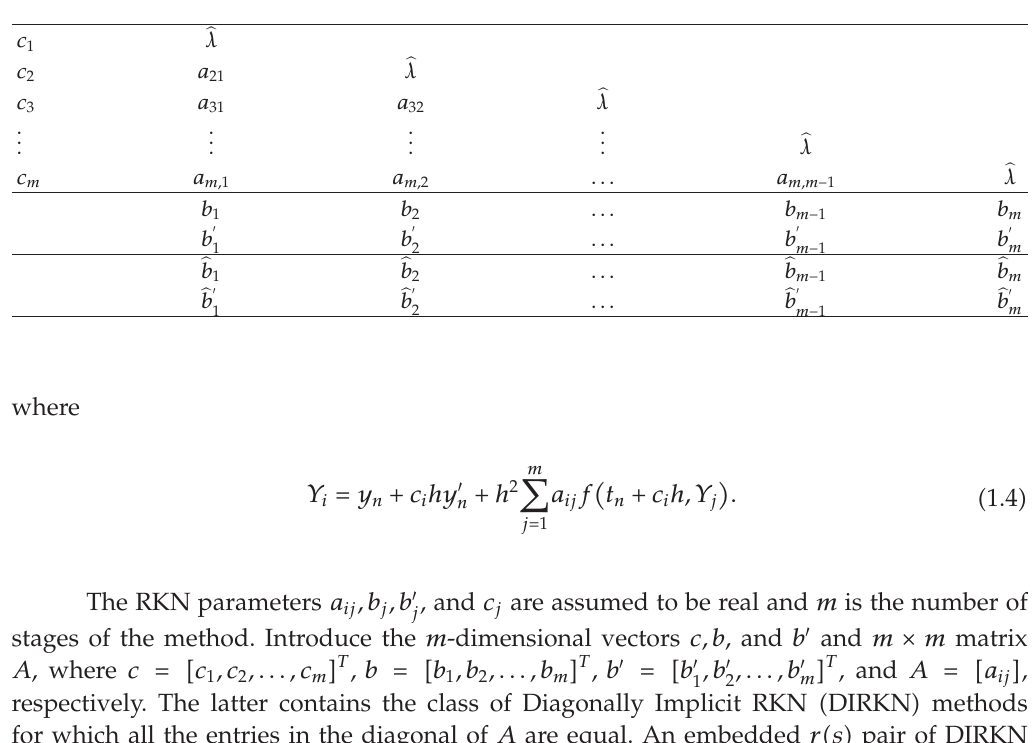
Table 1: m -stage DIRKN